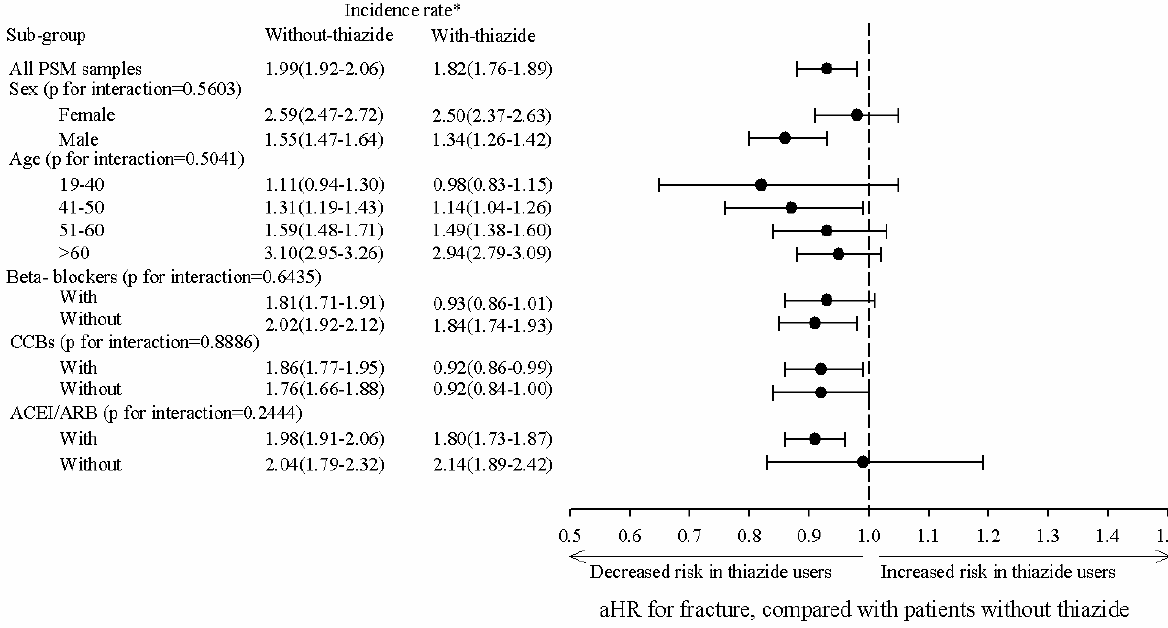
Figure 3. Subgroup analysis of adjusted hazard ratio for fractures in patients with thiazide compared with patients without thiazide. * per 1000 person-months; aHR (adjusted Hazard Ratio) adjusted variables including age, sex, comorbidities and medication; CCBs: Calcium Channel Blockers; ACEIs: Angiotensin-Converting Enzyme Inhibitors; ARB: Angiotensin Receptor Blockers.